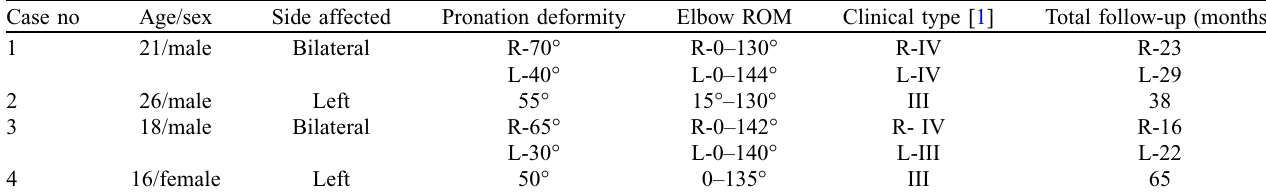
Table 1. Details of patients.